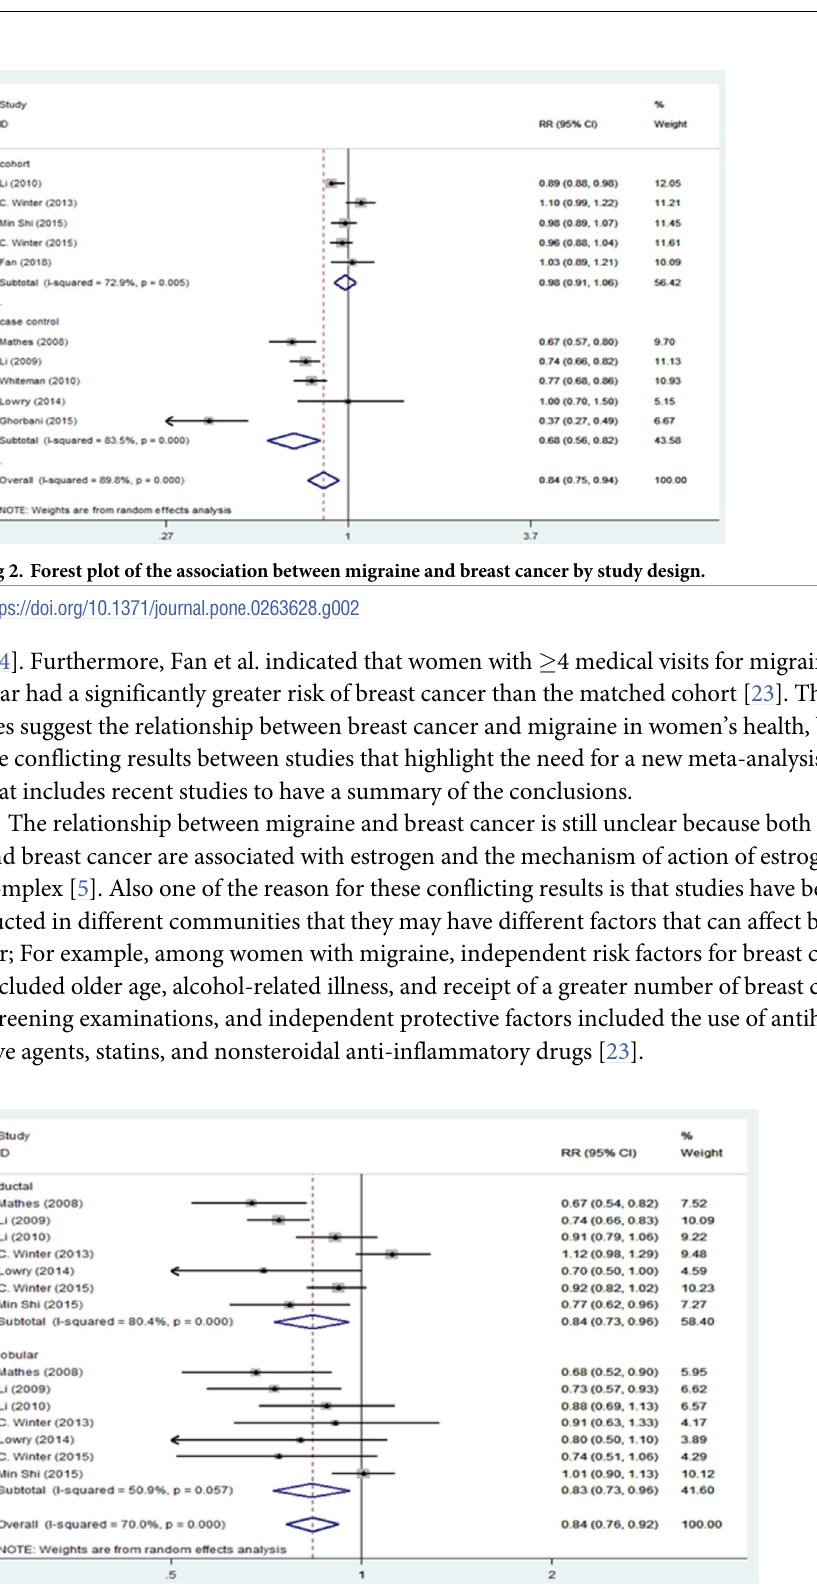
Fig 3. Forest plot of the association between migraine and breast cancer by histologic subtype.